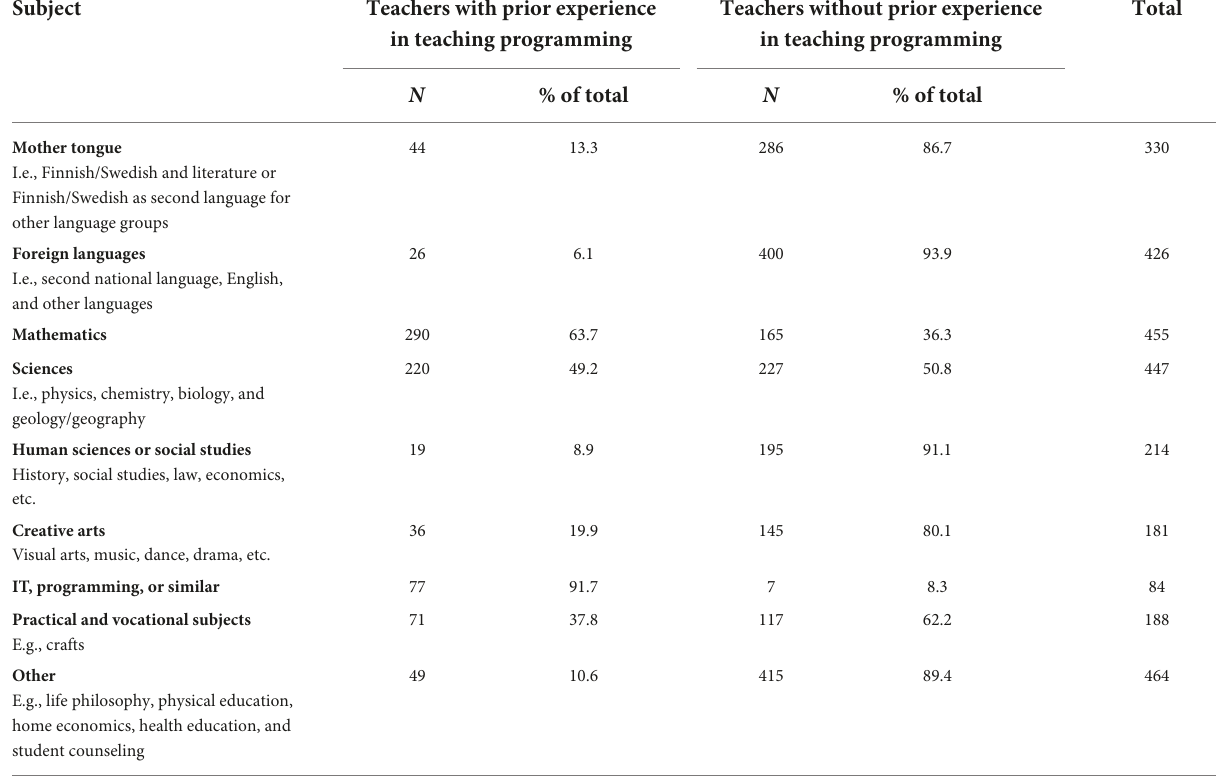
TABLE 3 Subjects taught by the respondent teachers with and without prior experience in teaching